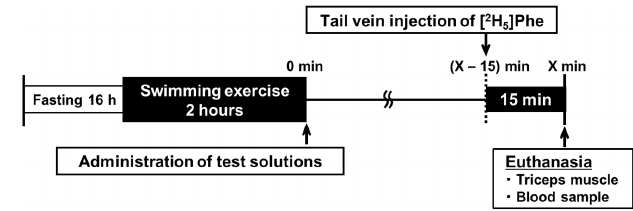
Figure 1. The experimental protocol. Acidified milk and skim milk groups: X = 30, 60, 90, or 120. Exercise-only control group (without administration of either test solution): X = 15.